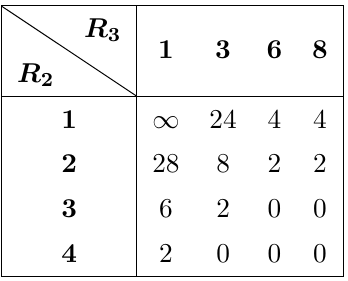
1. Maximal number of VL fremions with the mass of 10 TeV, which al- lows for perturbative gauge couplings below 10 15 GeV. Y F = 0 is assumed.